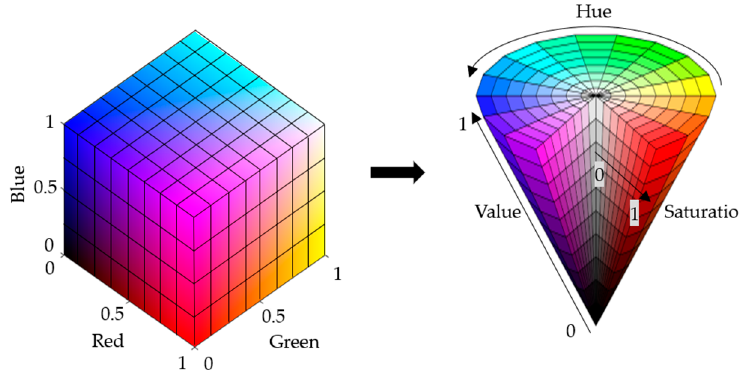
Figure 18. RGB color space to HSV color space conversion.